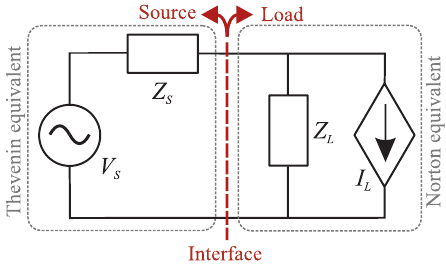
Figure 2. Source-load equivalent circuit for a grid-connected